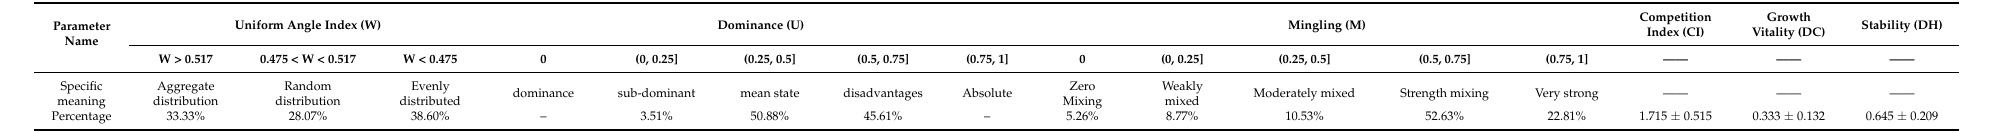
Table 5. Structural and non-structural parameters of the overall plant community of traditional villages in karst topographic regions of the Zunyi.